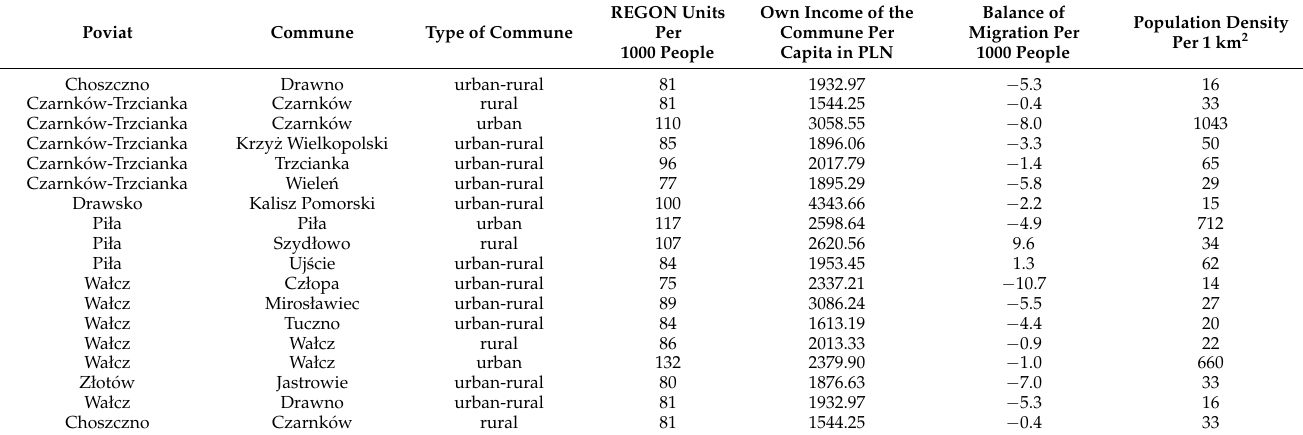
Table 1. Selected features of communes characterizing the level of socio-economic development of the analyzed area in 2019.